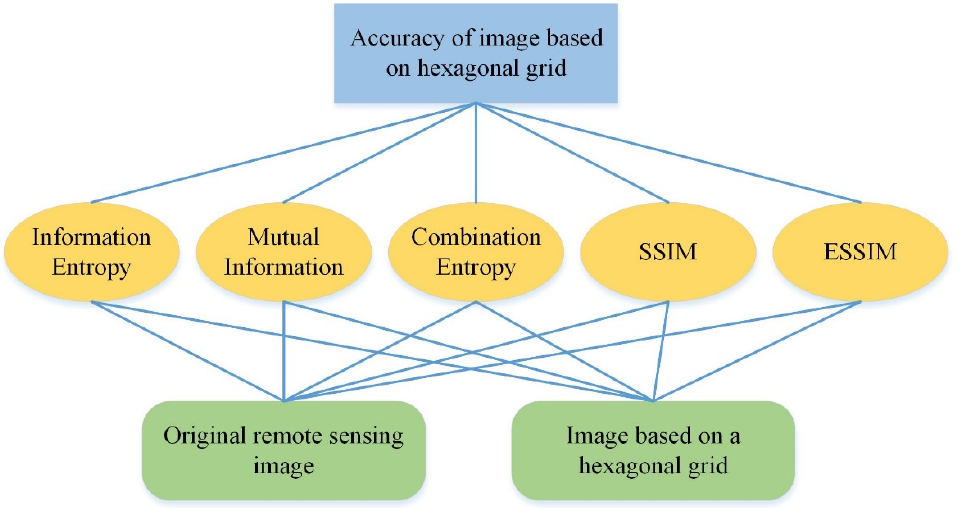
Figure 8. Basic structure of AHP(Analytic Hierarchy Figure 8 . Basic structure of AHP(Analytic Hierarchy Process).